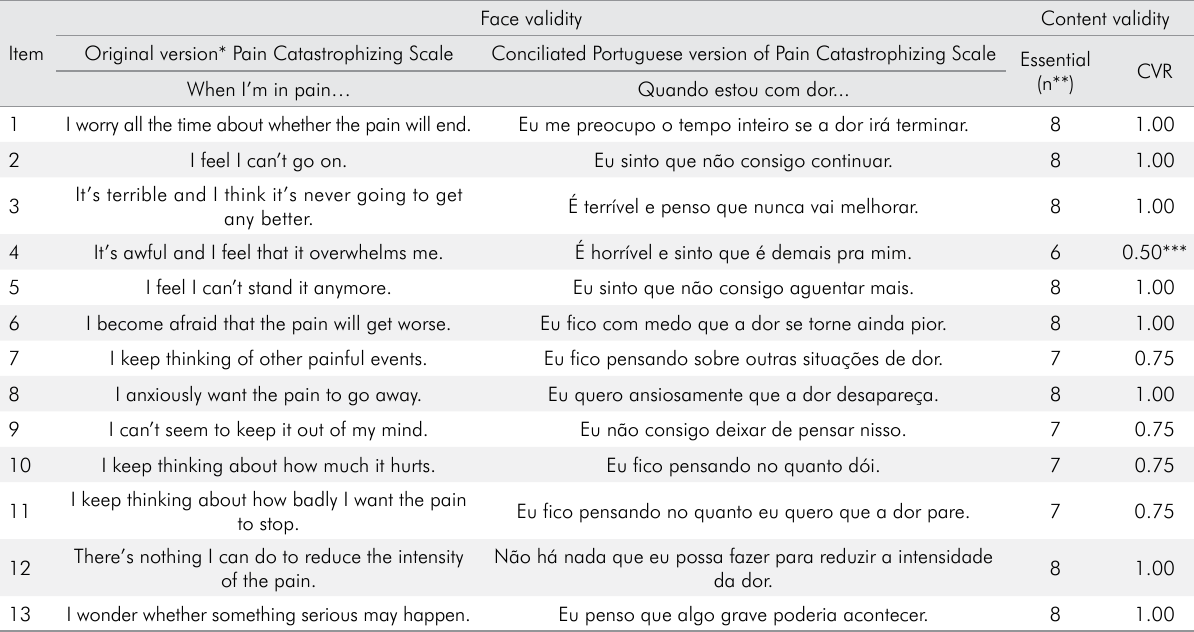
Table 1. Conciliated Portuguese version and the content validity ratio (CVR) for items of the Pain Catastrophizing Scale.